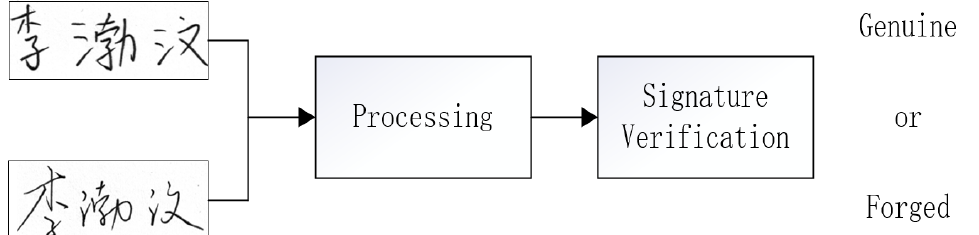
Figure 1. The overall framework of the verification system. (Example of Chinese signature in the figure: Li Bowen)